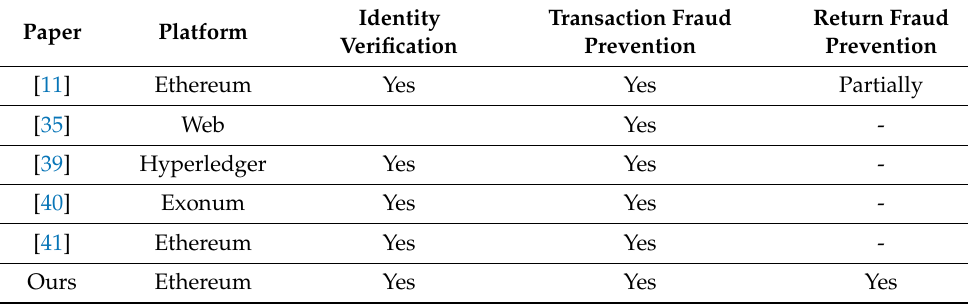
Table 3. Comparison of other